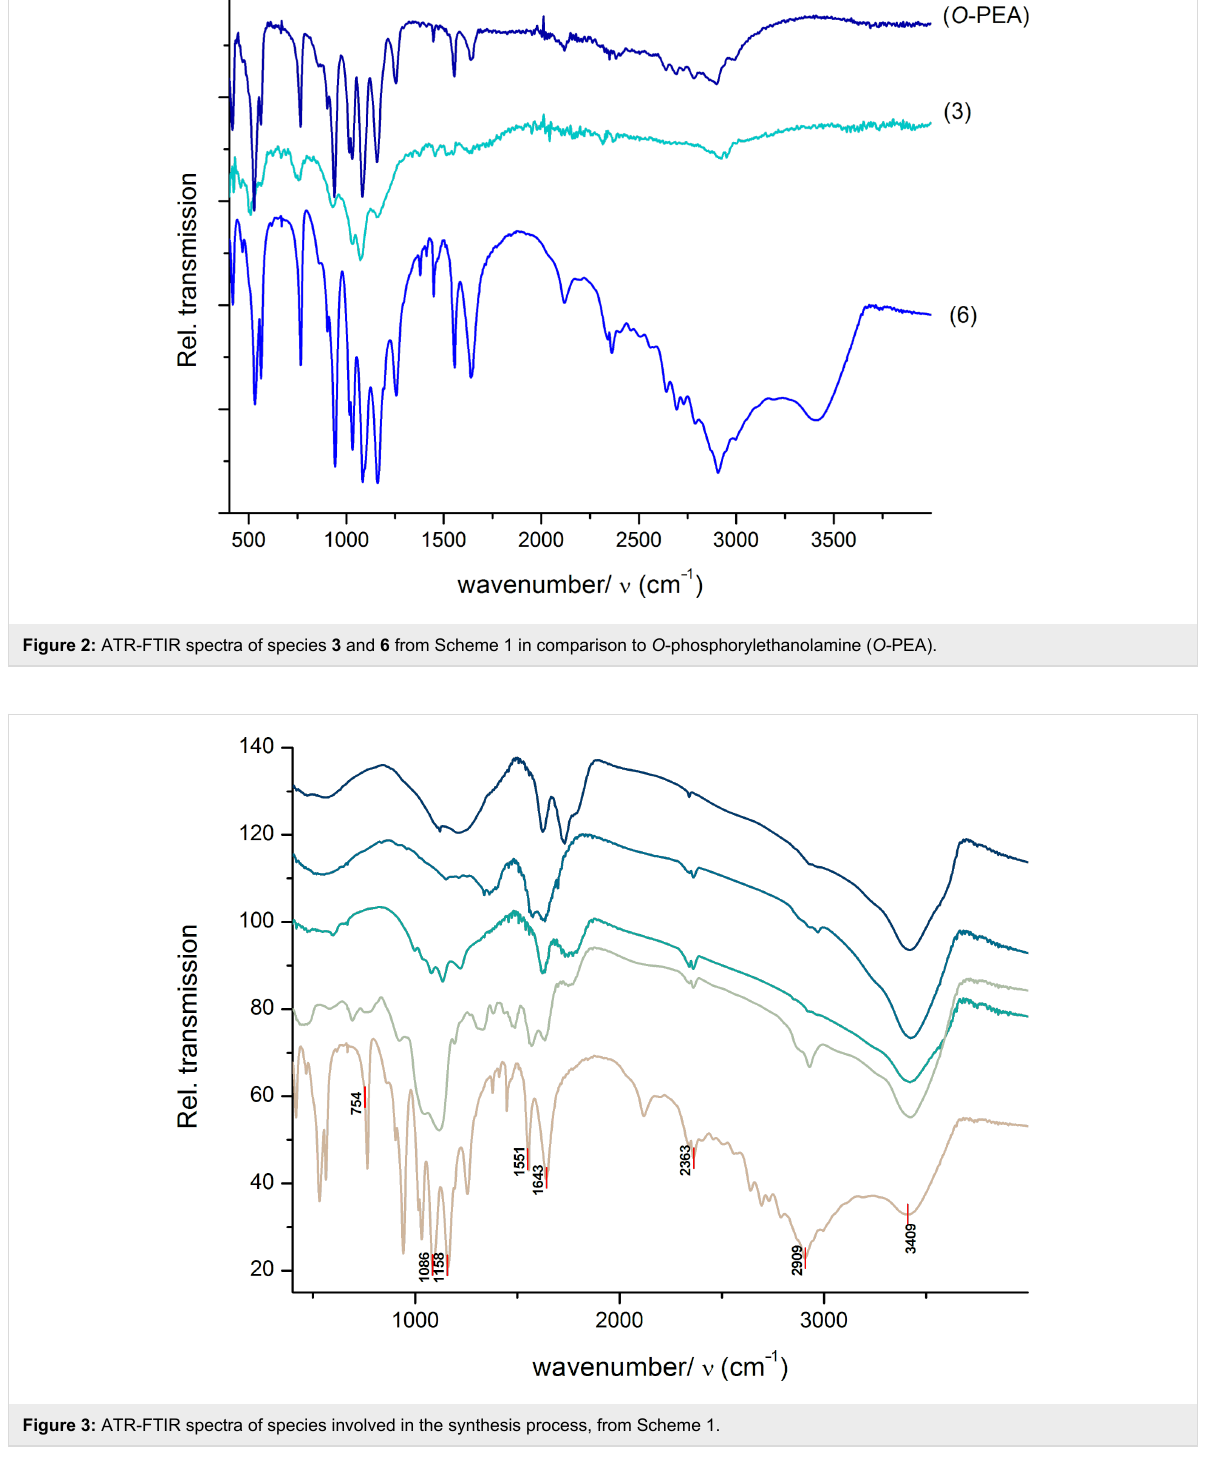
Table S1 (please see the Supporting Information File 1) summa- rizes the characteristic absorption bands of the qualitative analysis from the synthesized species by IR spectroscopy [40,41]. The evaluation of the surface functionalization of DND